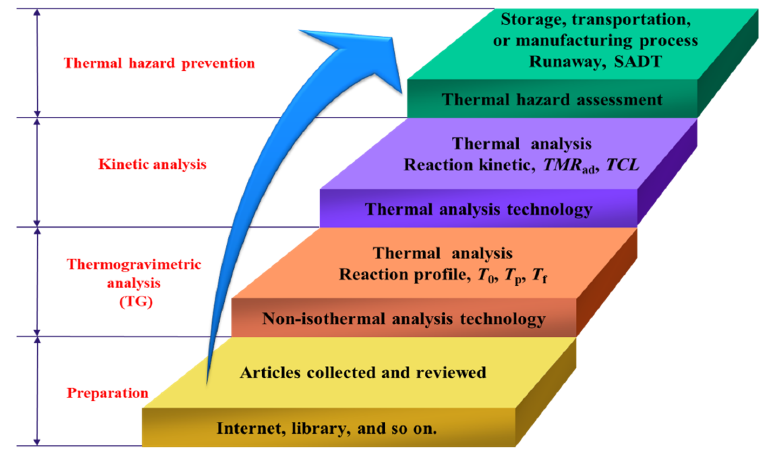
Figure 2. The chemical structure of AIBA.